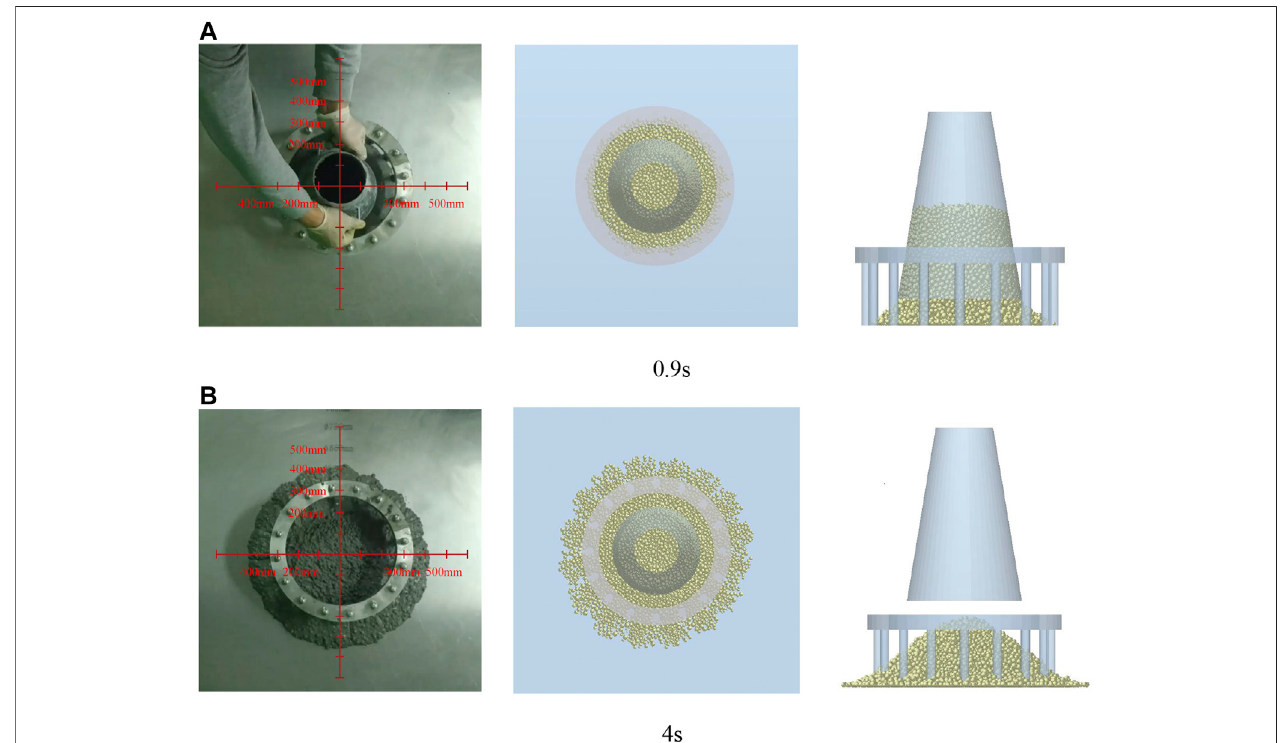
FIGURE 8 | Comparison between J-Ring test process and DEM simulation of B1 concrete: (A) 0.9 s and (B) 4 s.